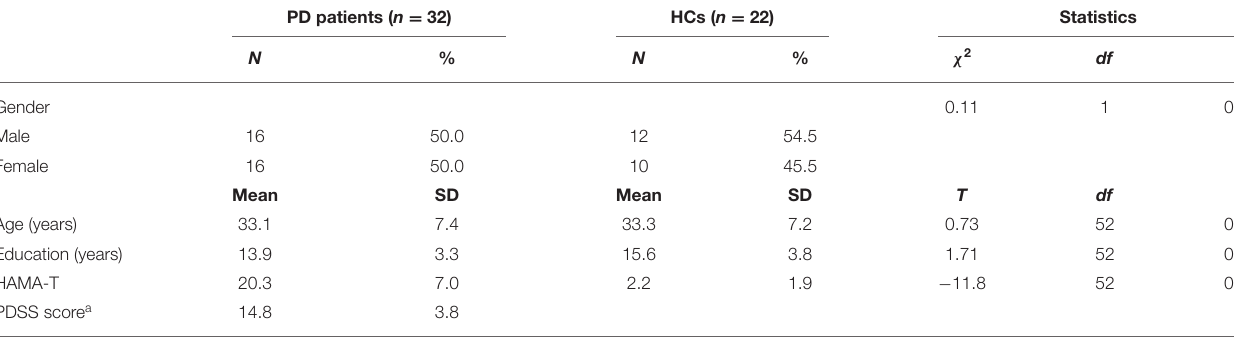
TABLE 1 | Comparison of the demographic and clinical variables between PD patients and